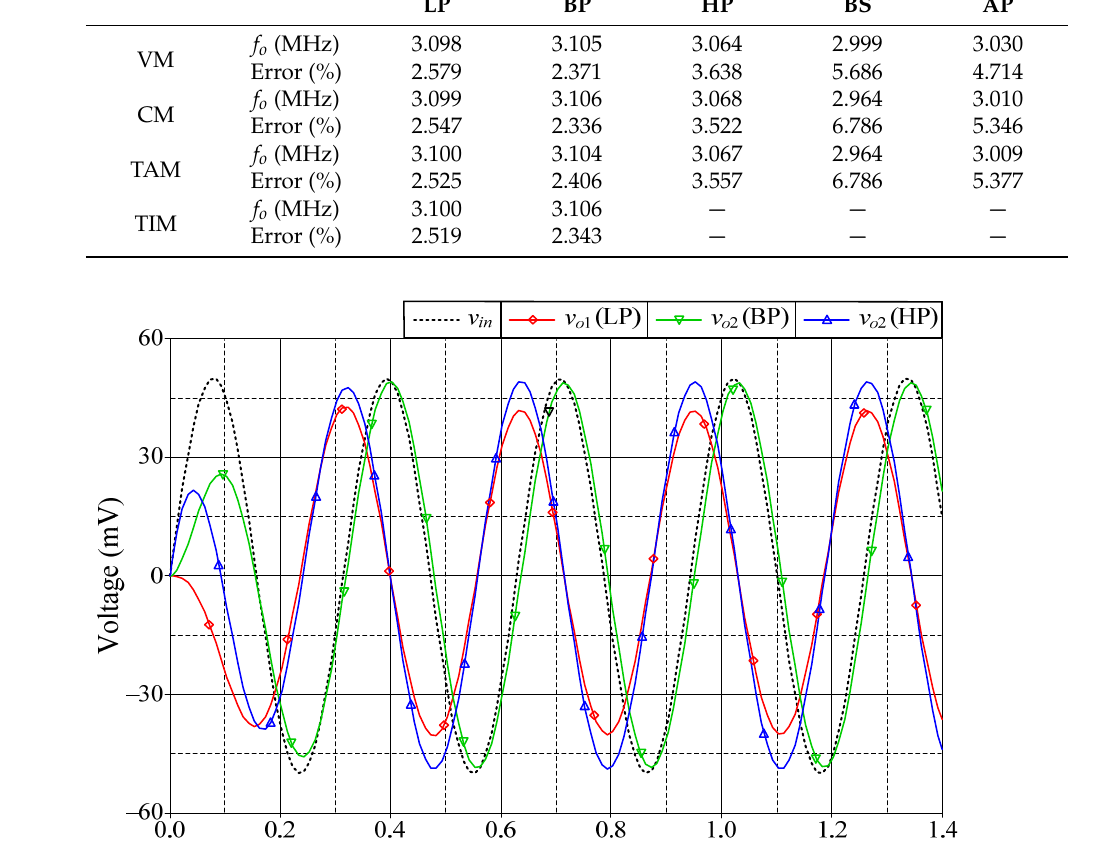
Figure 12. Time-domain responses of the LP, BP, and HP filters in TAM.